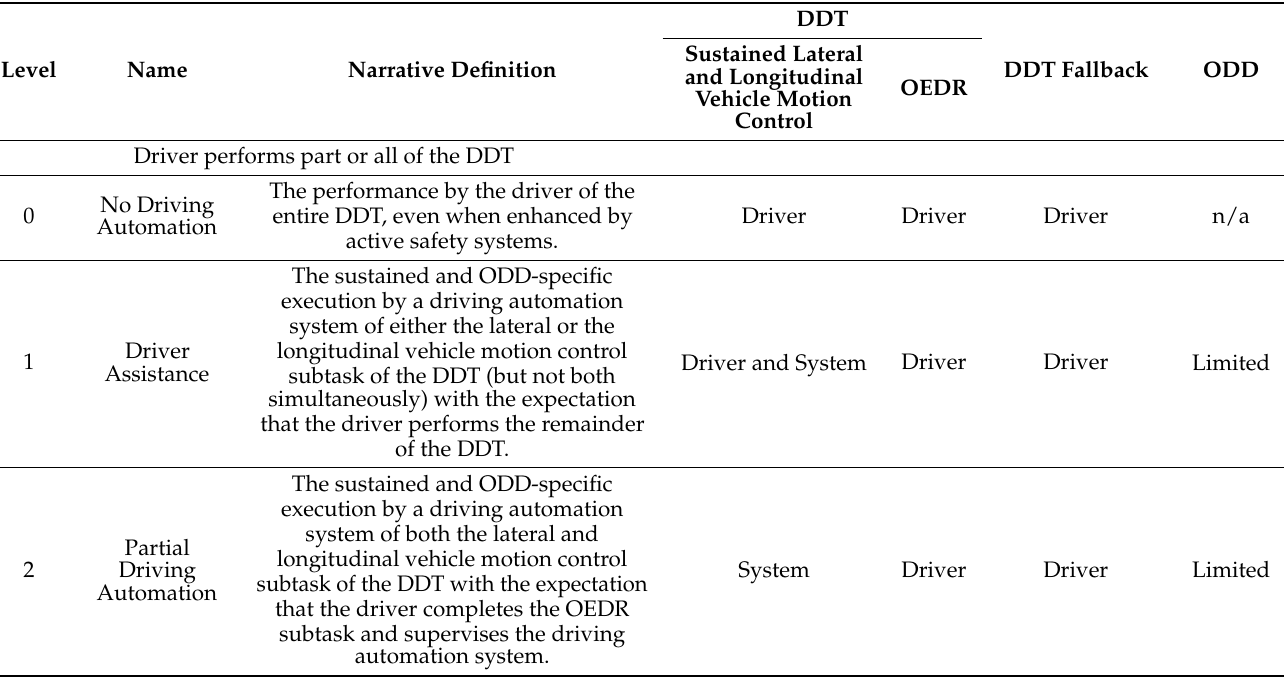
Table 2. Level of driving automation proposed by SAE